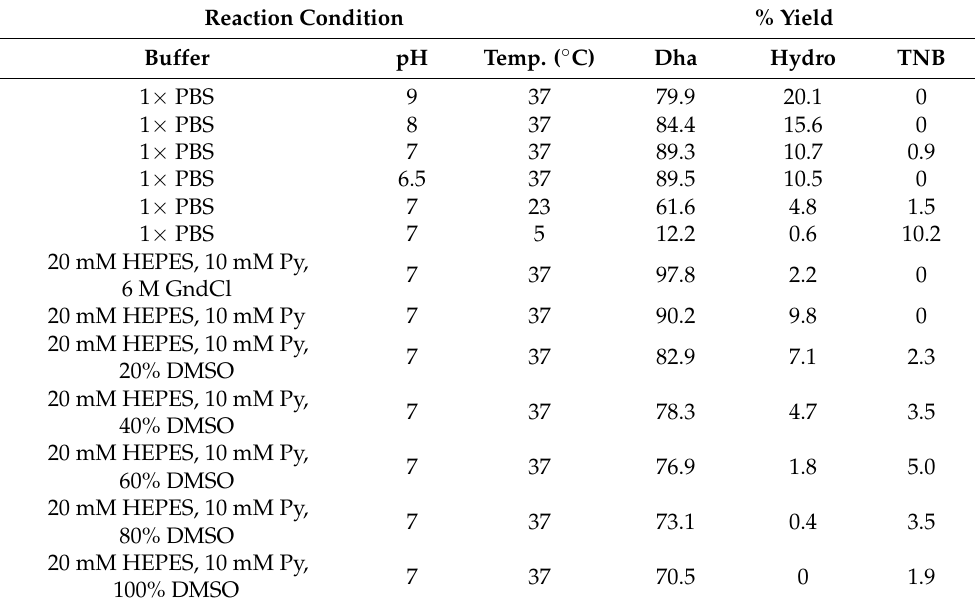
Table 1. Quantitation of NTCB induced Dha formation of